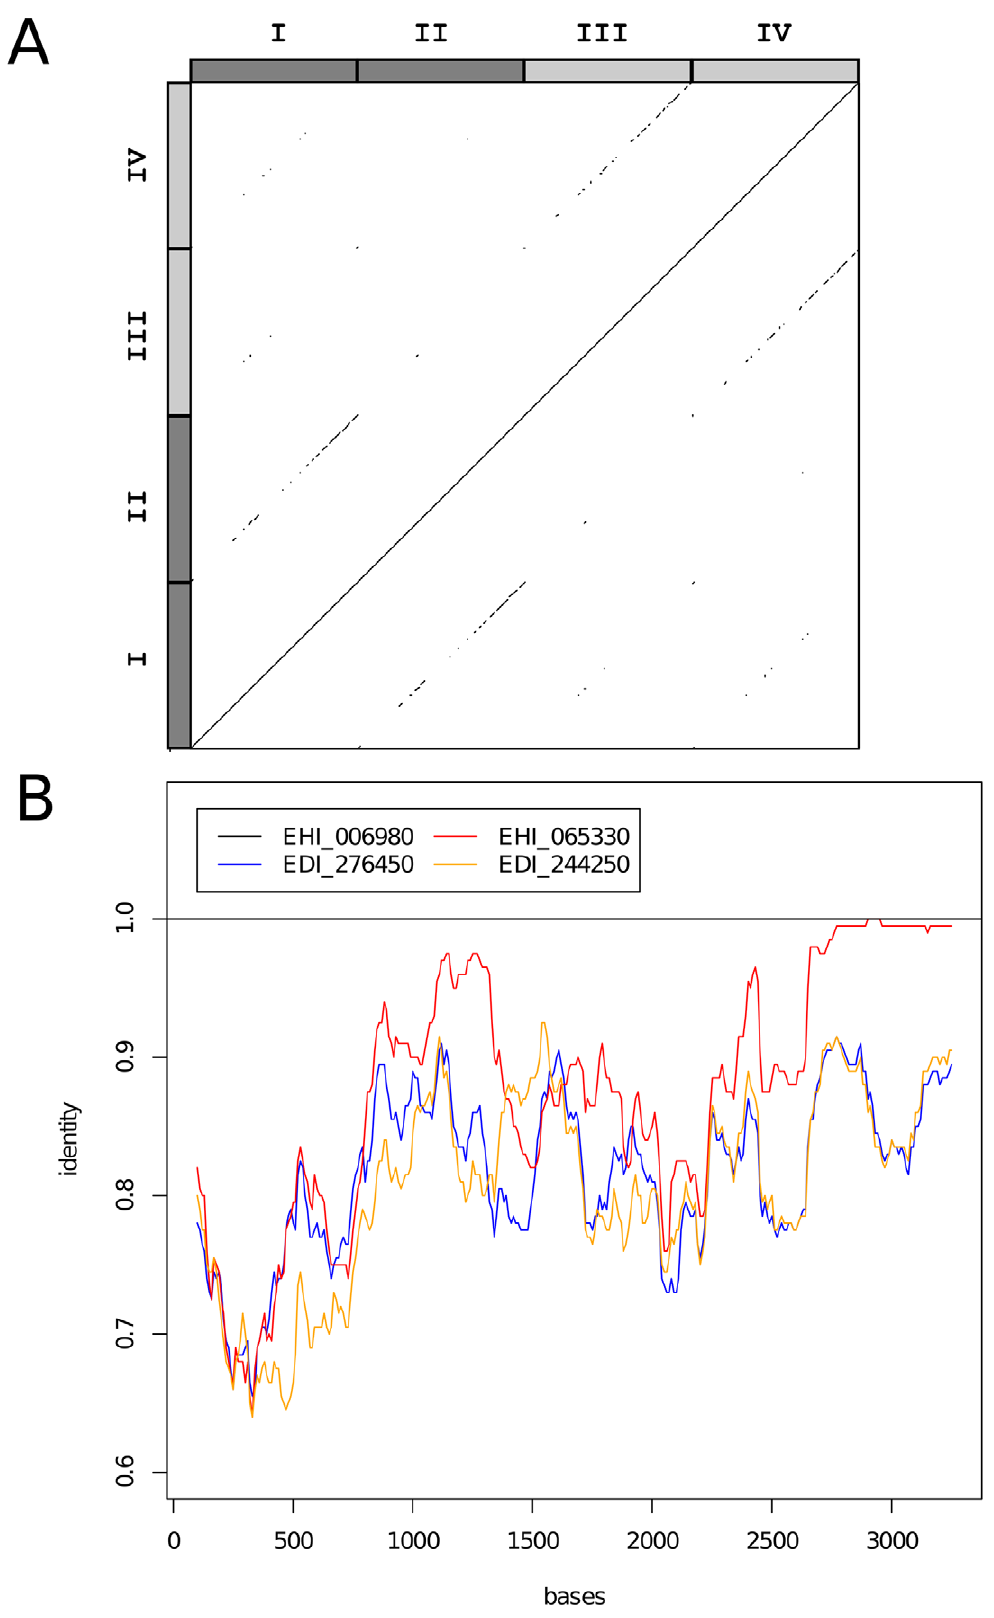
Figure 5. Sequence similarity among intermediate-chain lectin subunit genes. (A) Dotplot indicating identical 40 bp windows among all igl genes. Dark grey boxes I and II represent E. histolytica genes EHI_006980, EHI_065330; light grey boxes III and IV represent E. dispar genes EDI_276450 and EDI_244250. (B) Sequence identity (to gene EHI_006980) calculated for a 200 bp window, moving in 10 bp increments across a multiple alignment of igl genes.